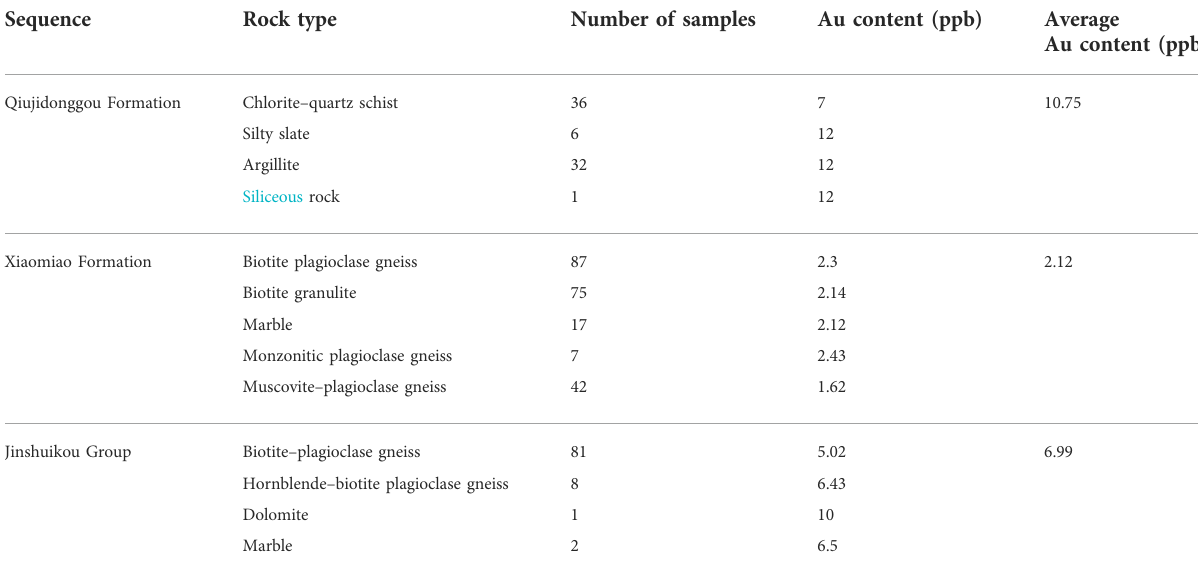
TABLE 1 Average gold content in the main sequences of the Wulonggou gold